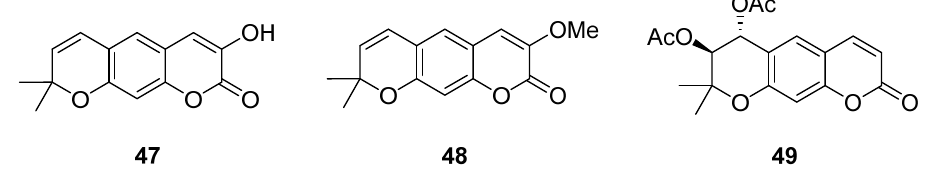
Figure 8. Structure of wedelolactone, a coumestan derivative.